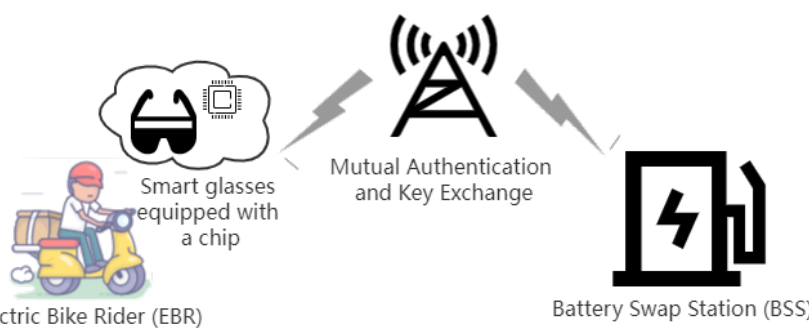
Figure 1. A typical architecture of